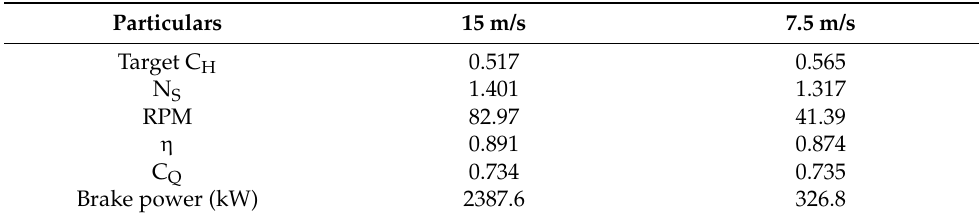
Figure 12. Specific speed–head coefficient curves of the axial flow pump. Table 4. Performance of the